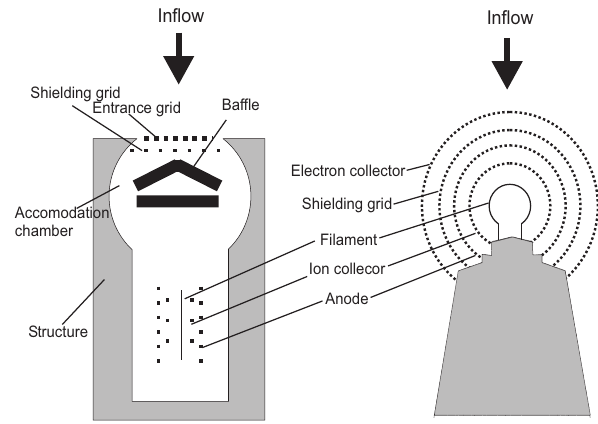
Fig. 1. Sketches of the ionization gauges TOTAL (left) and CONE (right). For more technical details on the gauges (dimensions, volt- ages, etc.), see the papers by Hillert et al. (1994) and Giebeler et al.